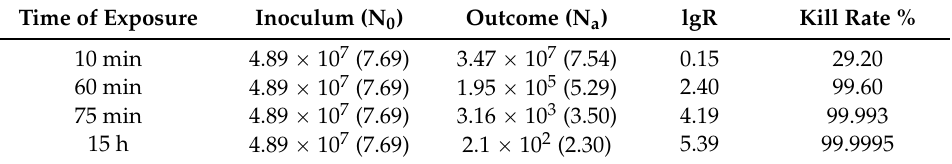
Table 1. Kill rate of Legionella pneumophila serogroup (sg) 1 exposed to 600 ppm Peroxy Ag + according to European Standard 13623 (in vitro test).